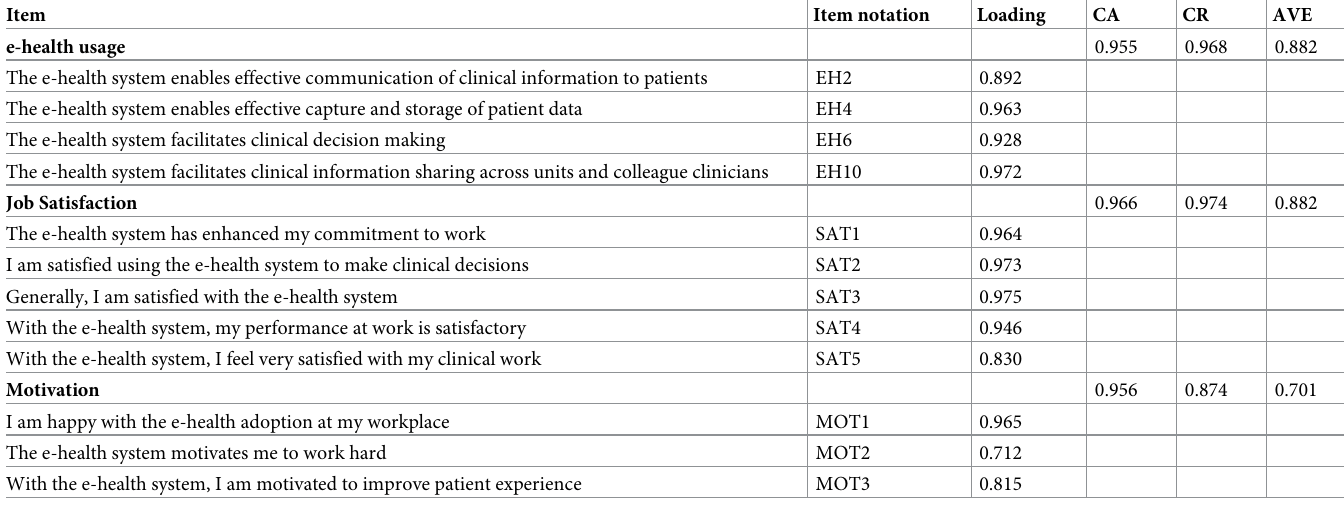
Table 1. Test results of standardised factor loadings and